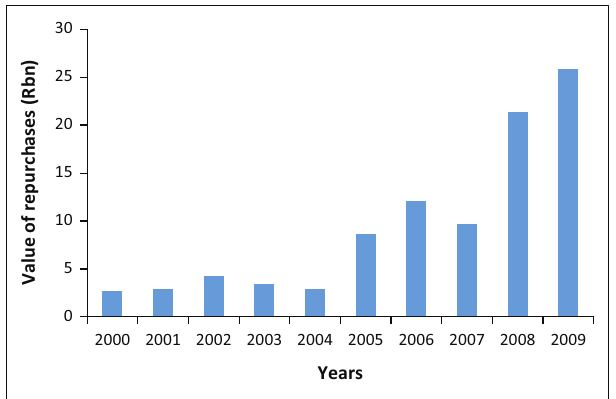
FIGURE 3: Value of repurchases per